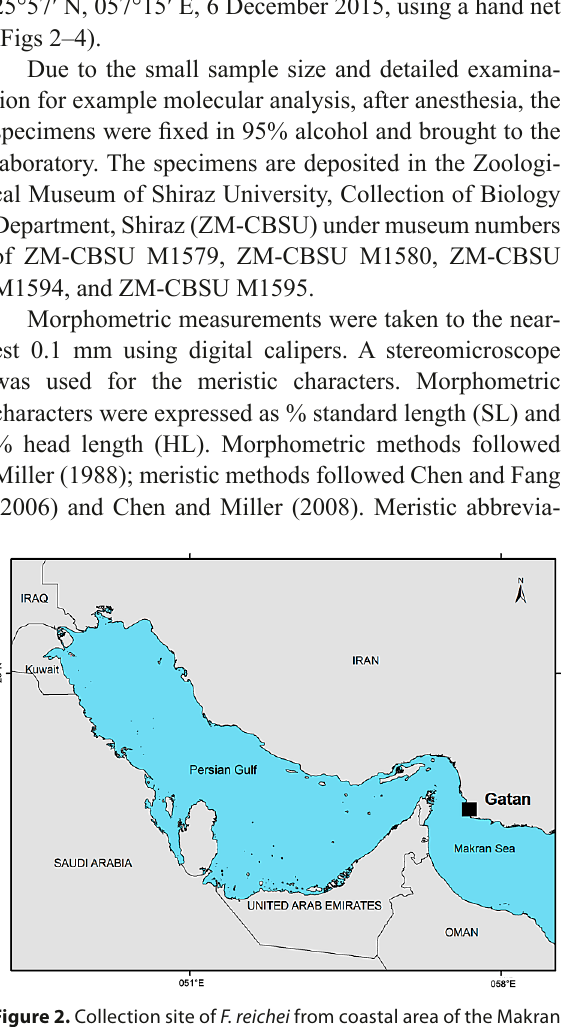
Figure 2. Collection site of F. reichei from coastal area of the Makran Sea, Iran (25°57’ N, 057°15’